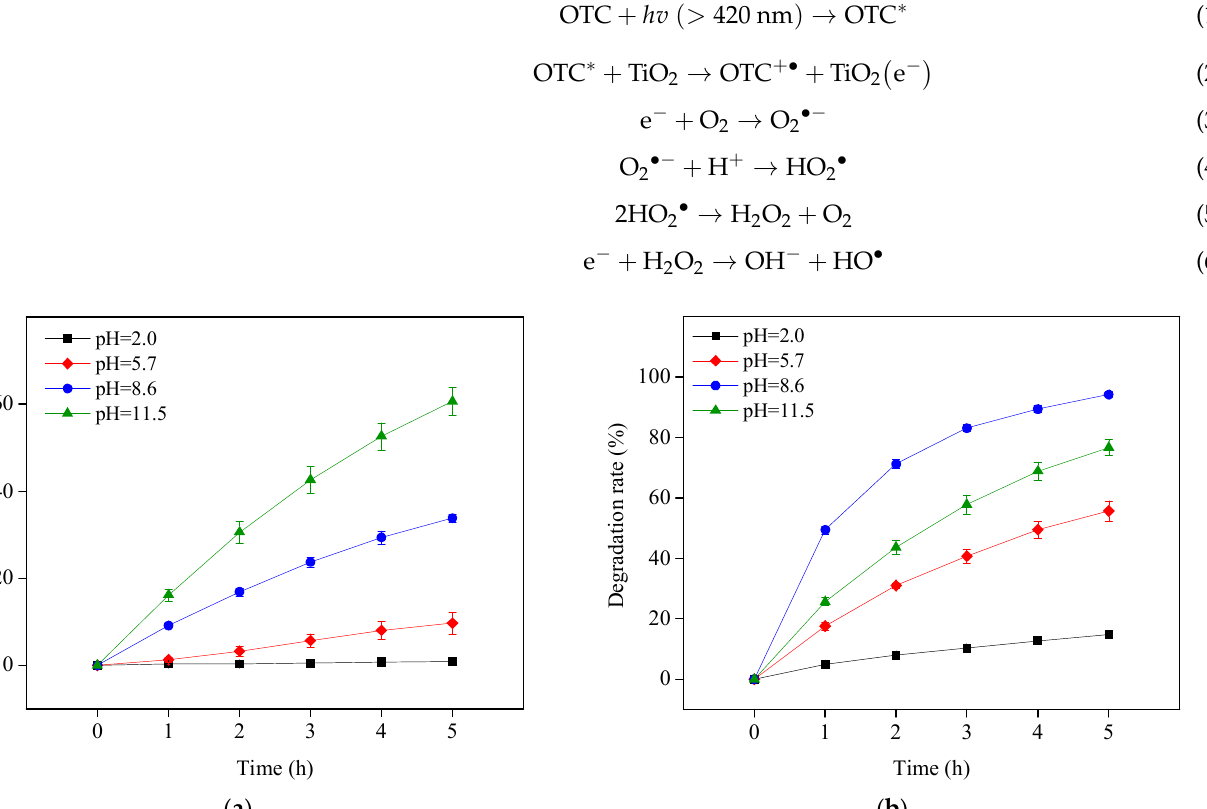
Figure 1. Photolysis ( a ) and TiO 2 -assisted photosensitized degradation ( b ) of OTC under visible light irradiation at different pH values. Experimental conditions: [OTC] 0 = 10 mg L − 1 , [TiO 2 ] 0 = 0.5 g L − 1 , 50 mM phosphate buffer.